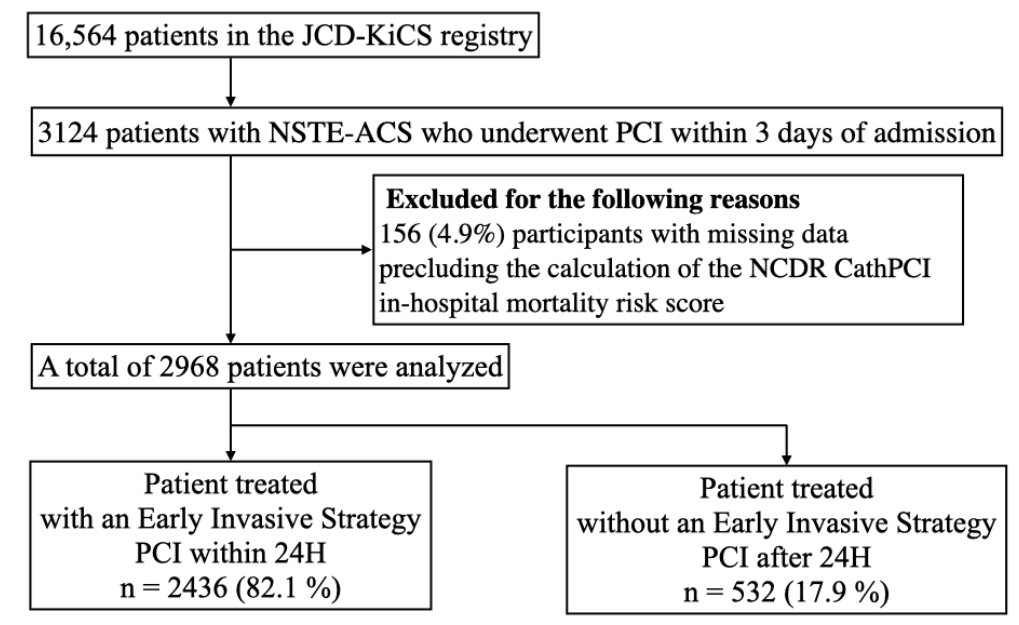
Figure 1. Study flowchart. Abbreviations: JCD-KiCS, Japan Cardiovascular Database-Keio interhospital cardiovascular studies; NSTE-ACS, non-ST elevation acute coronary syndrome; PCI, percutaneous coronary intervention; NCDR, national cardiovascular data registry; H, hour.